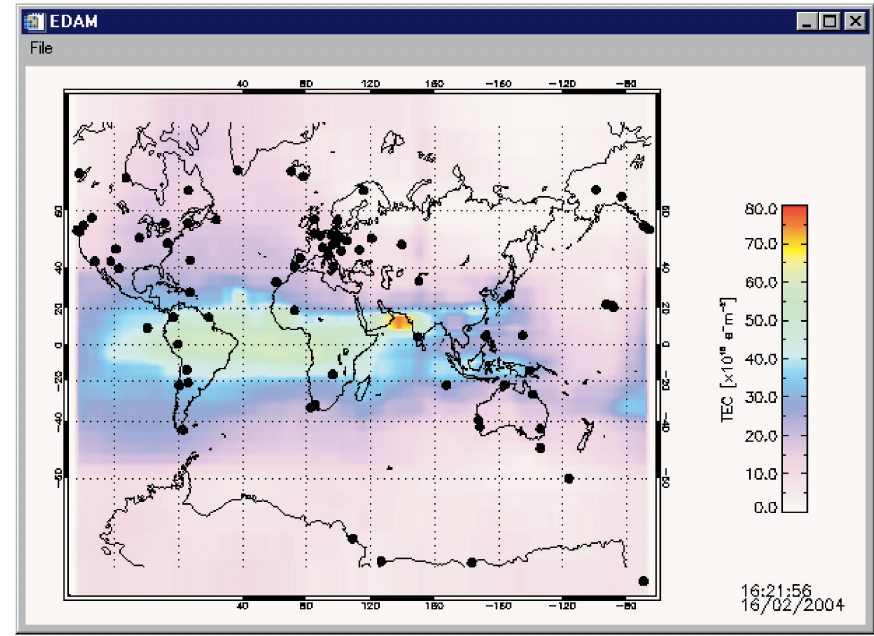
Fig. 7.8. Screen grab showing vertical TEC generated from the EDAM electron density analysis. The dots show the locations of contributing IGS